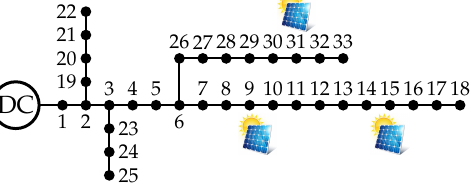
Figure 3. Electrical configuration of the IEEE 33-bus grid for monopolar DC studies.